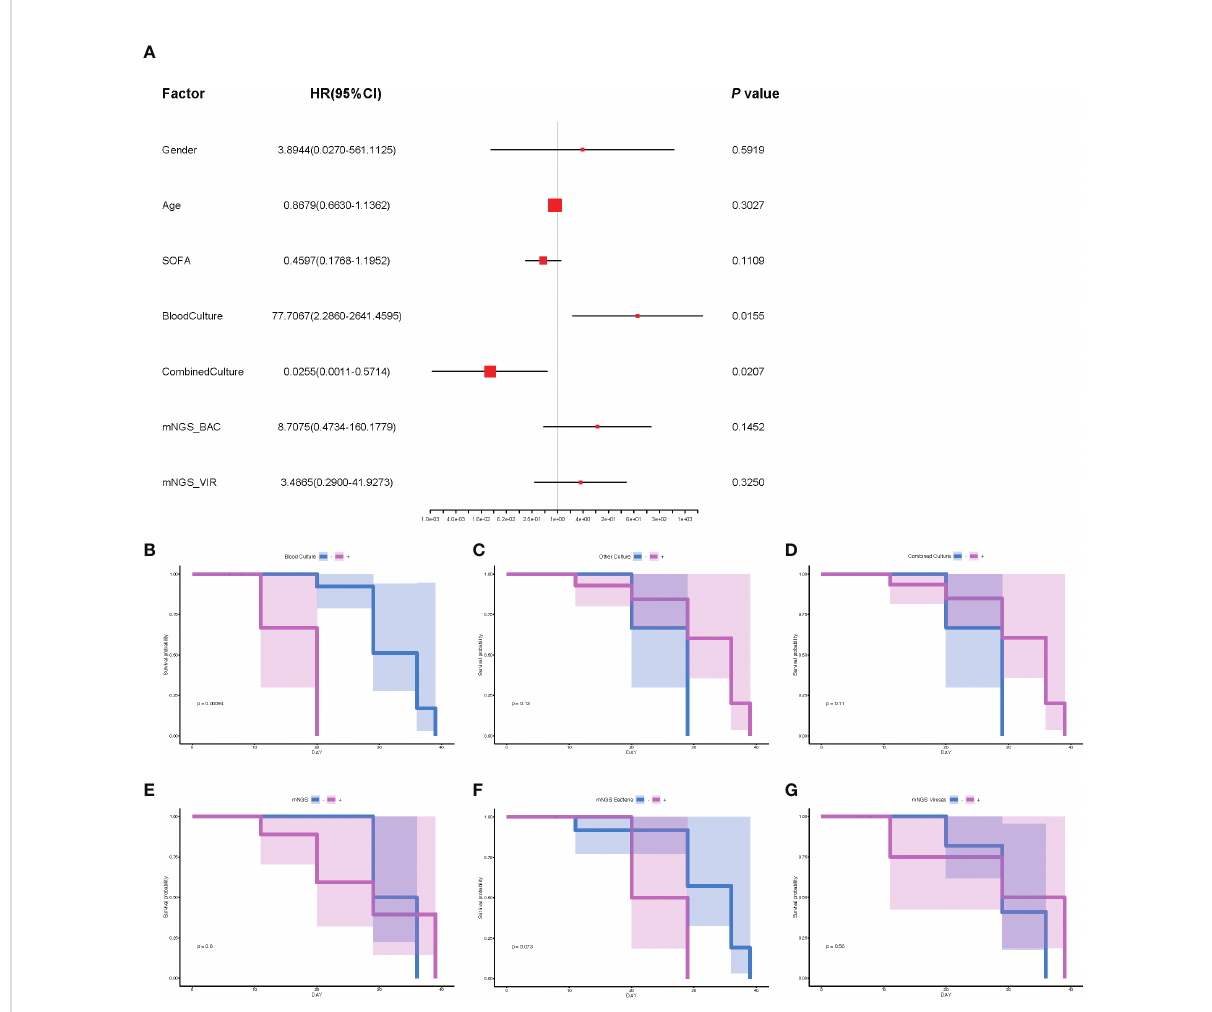
FIGURE 5 The analysis of prognosis based on the results of mNGS_BAC and mNGS_VIR. (A) The correlation of different factors with HR. (B – G) Survival probability of different cultural conditions and mNGS data. (B) Blood culture. (C) Other culture. (D) Combine culture. (E) mNGS. (F) mNGS bacteria. (G) mNGS viruses. Cox regression analysis for (A) and survival analysis for panels B – G. N = 27. HR, hazard ratio; mNGS, metagenomic next-generation